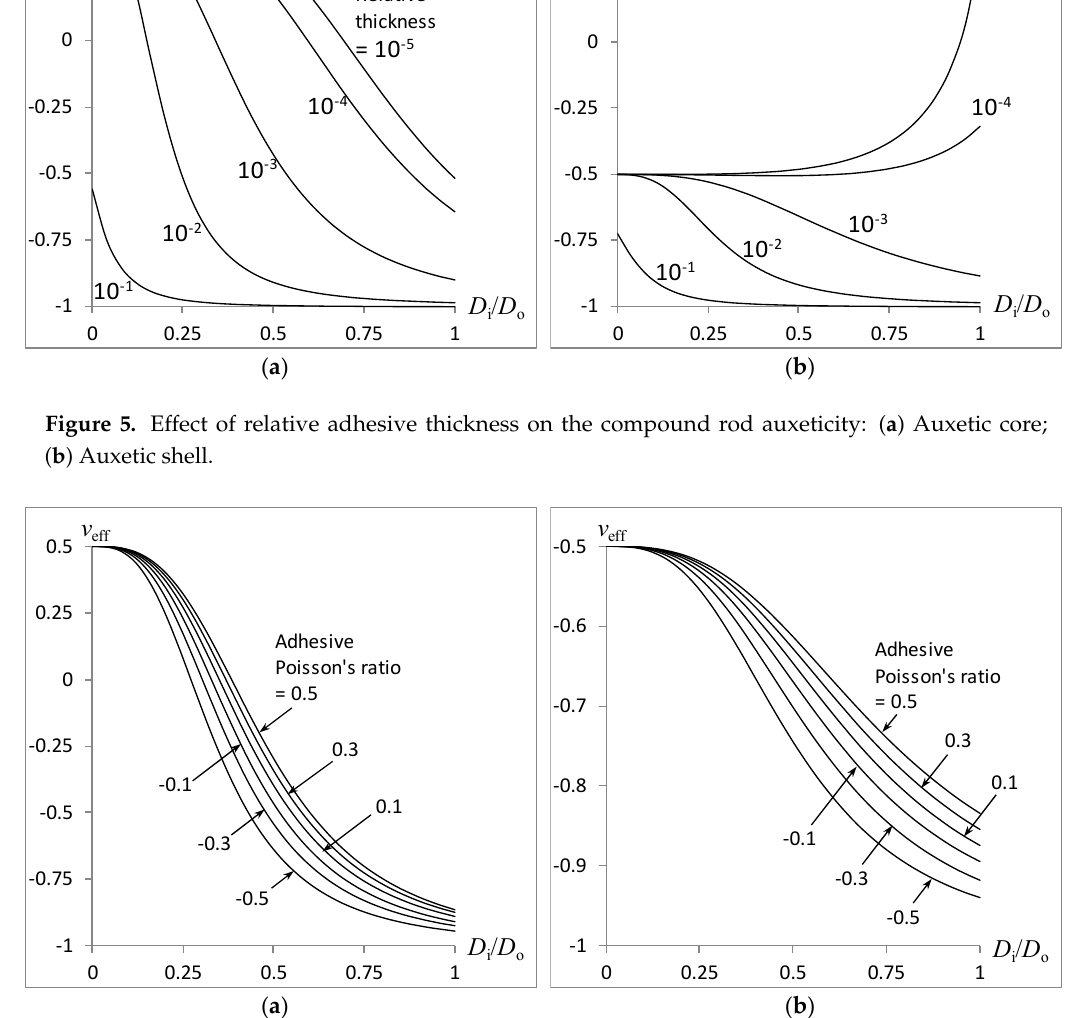
Figure 6. Effect of adhesive Poisson’s ratio on the compound rod auxeticity: ( a ) Auxetic core; ( b ) Auxetic shell.